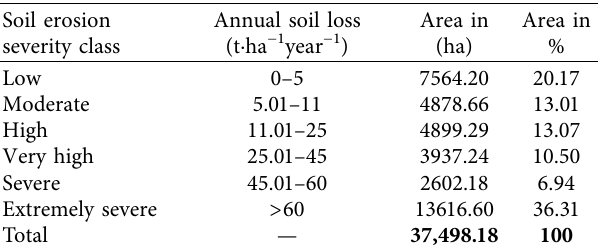
Figure 7: Map of (a) land use land cover types and (b) management factor (P-factor). Table 5: Soil loss severity class and annual soil loss at Antsokia